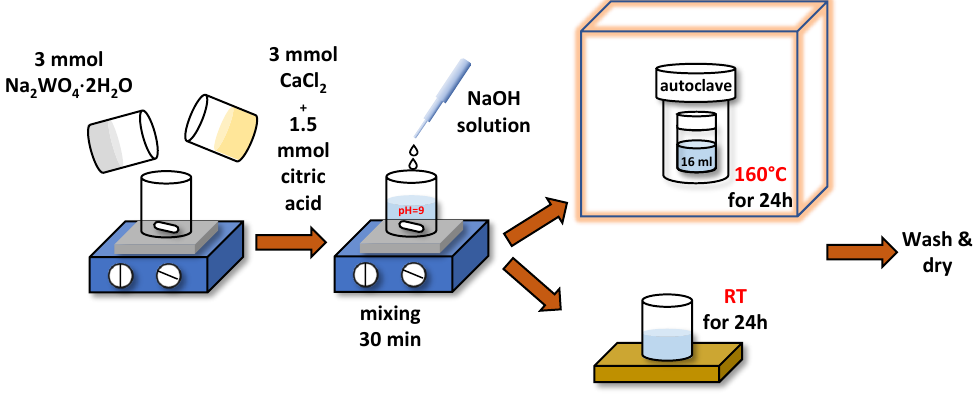
Figure 1. Schematics of CaWO 4 nanoparticle synthesis. See text for